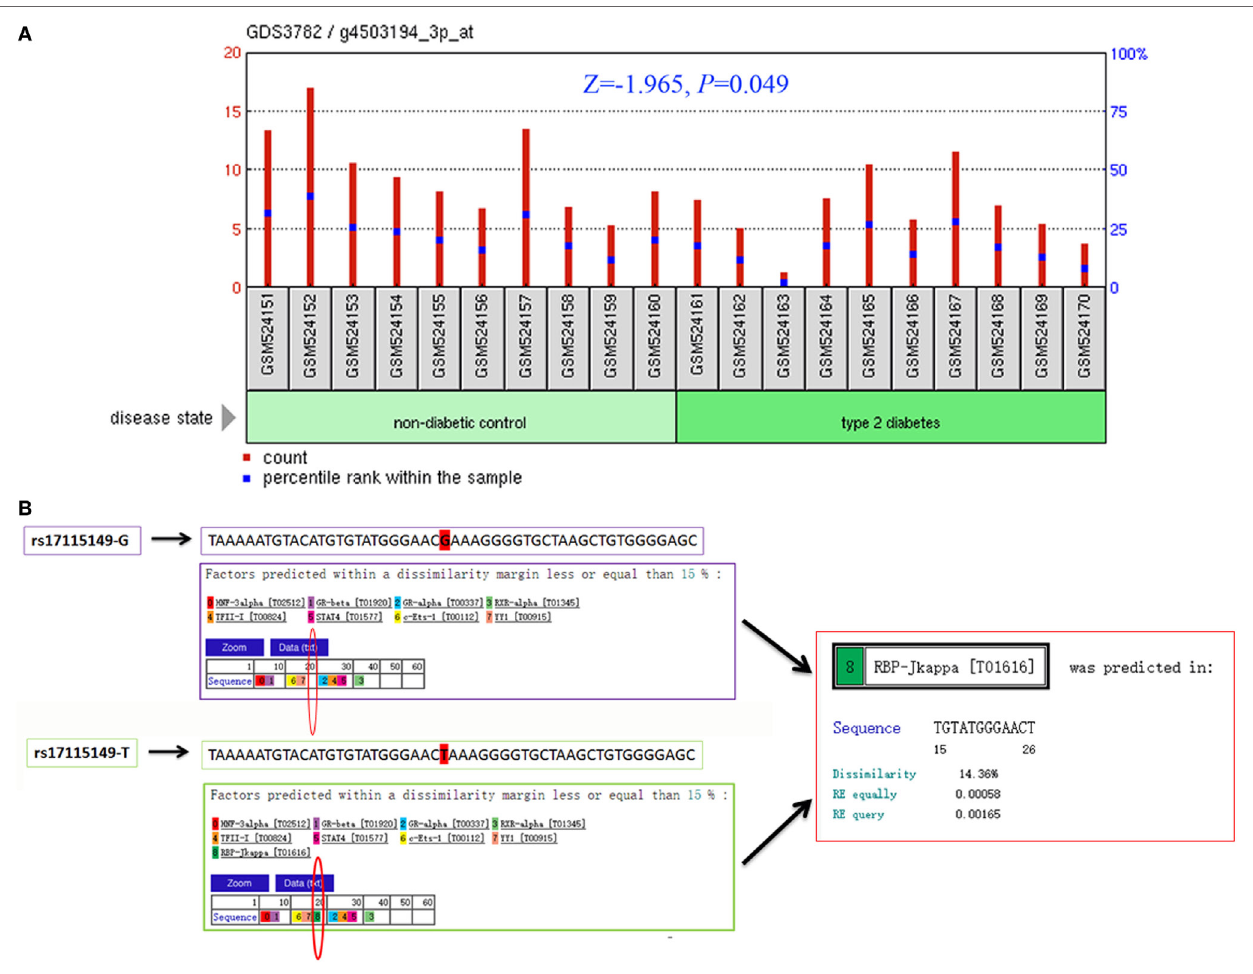
FigUre 2 | Bioinformatics analysis of the cytochrome P450 family 17 subfamily A member 1 (CYP17A1) gene and rs17115149 polymorphism. Analysis of CYP17A1 gene expression in type 2 diabetes mellitus patients compared with the healthy control group was performed using the high-throughput microarray gene expression database of GDS3782 data and Mann–Whitney U nonparametric test (a) . Bioinformatics analysis using data from the PROMO transcription factor binding site database showed that the mutant T allele at the rs17115149 polymorphism allowed binding to the RBP-Jkappa transcription factor (B)